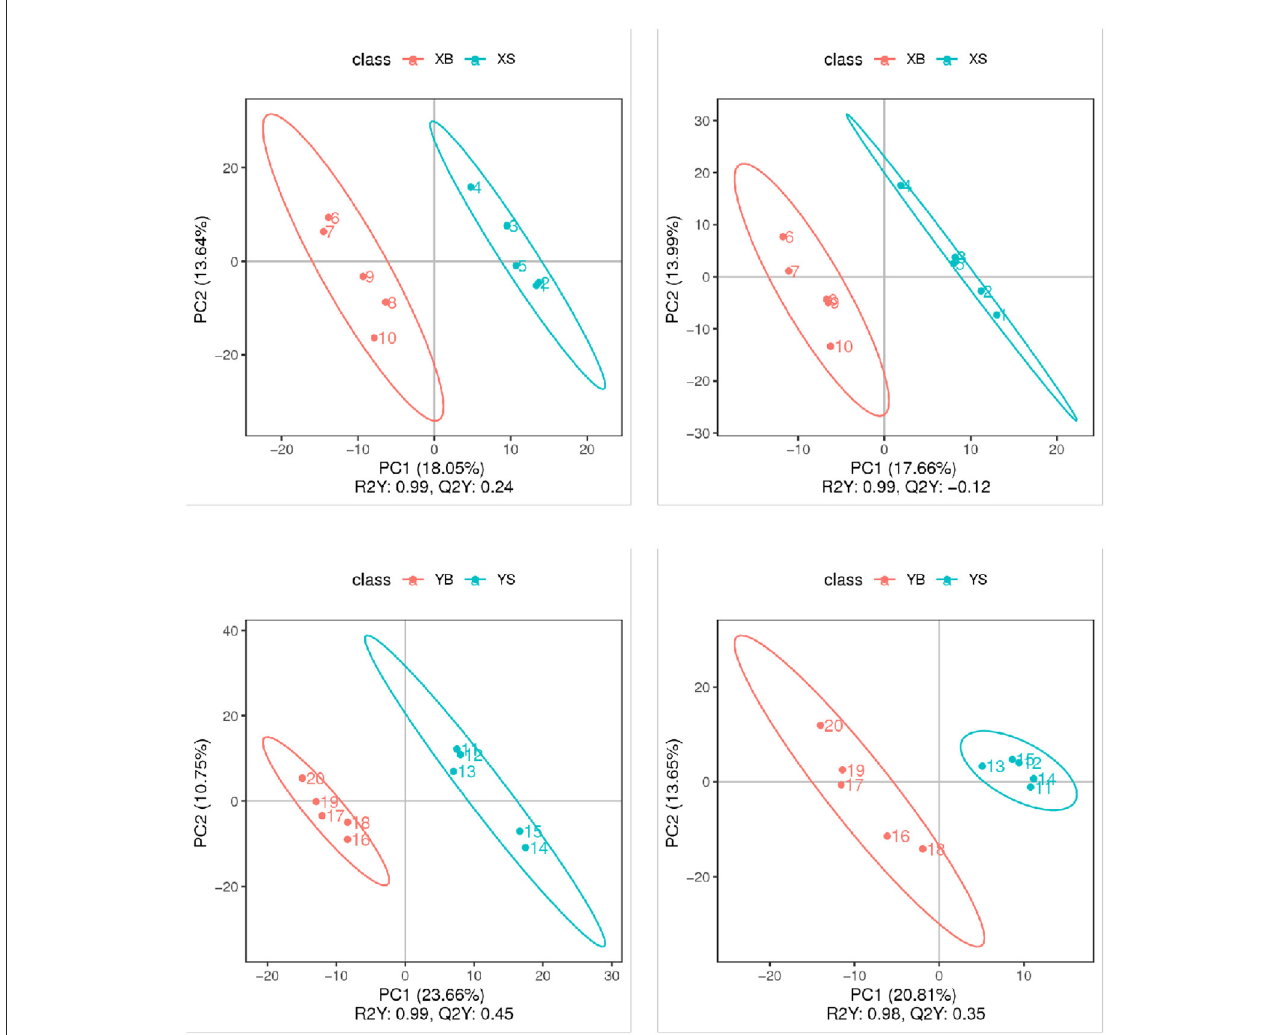
FIGURE4 PLS-DA score plot (positive and negative ion mode). The x -axis indicates the scores of samples in the first components; the y -axis is the scores of samples in the second major component [R2Y indicates the explained variation in the model; Q2Y indicates the predictability of the PLS-DA model. A good model requires R2Y >